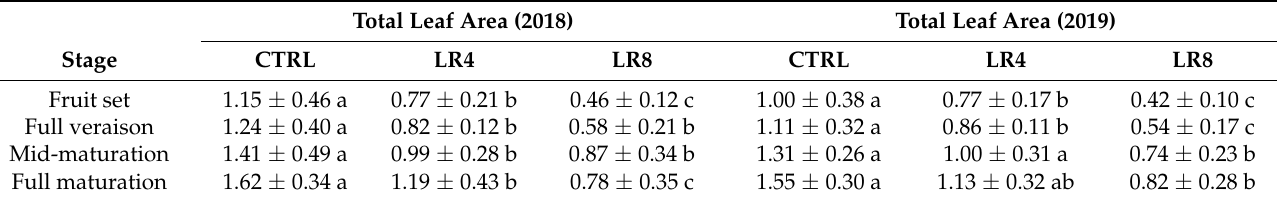
Data (mean ± SE, n = 10) were subjected to one-way ANOVA. Different letters within the same parameter and row indicate significant differences (LSD test, p ≤ 0.05).